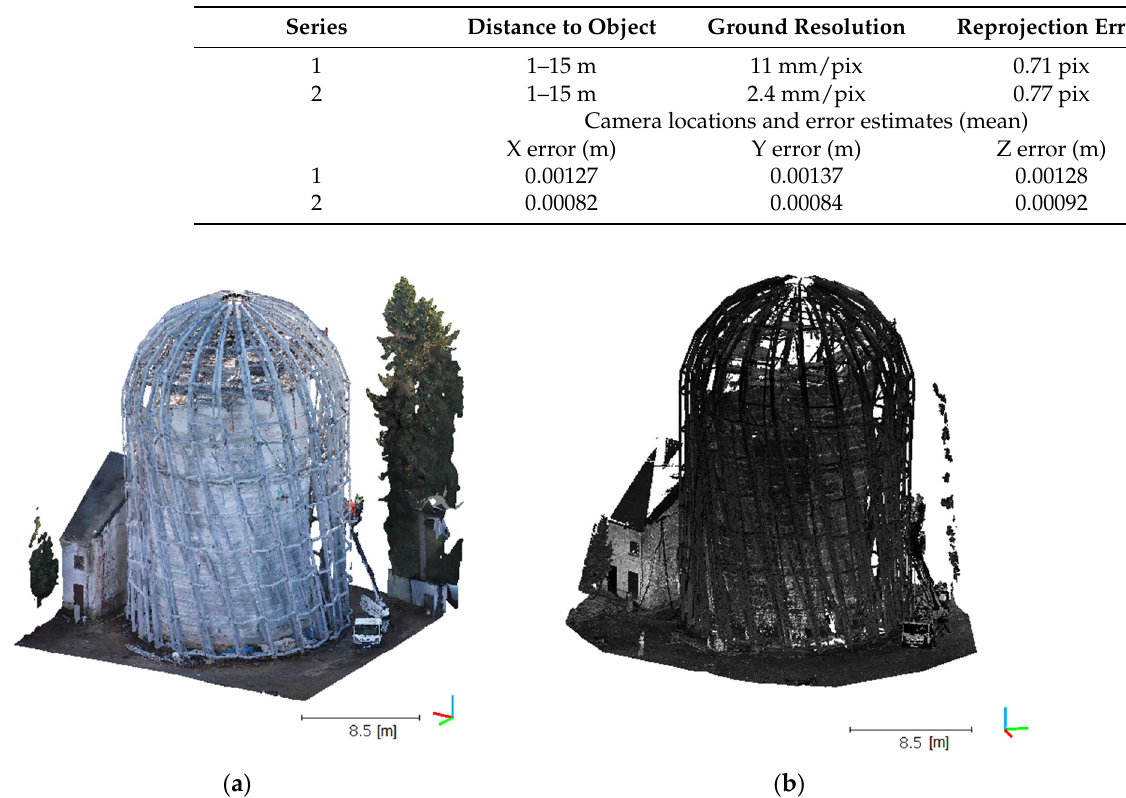
Figure 5. Developed primary point clouds for UAV ( a ) and TLS ( b ).